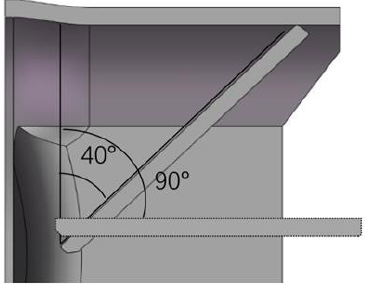
Figure 3. An MHV leaflet fully open (90 ° ) and fully closed (40 ° ).